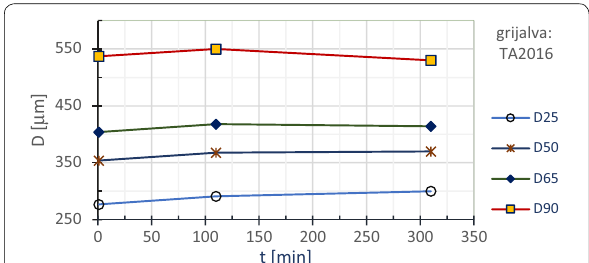
Fig. 10 Floc size variation in time with PTV during RAF experiments for the Grijalva river